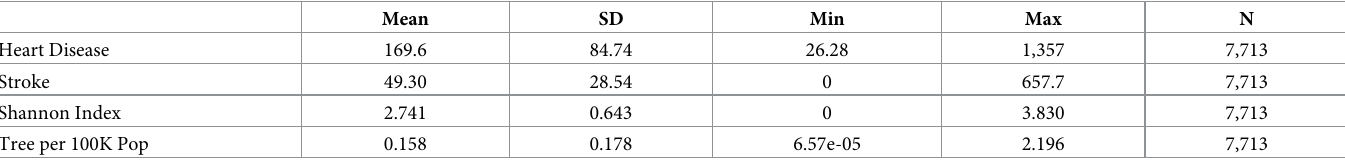
Table 1. Summary